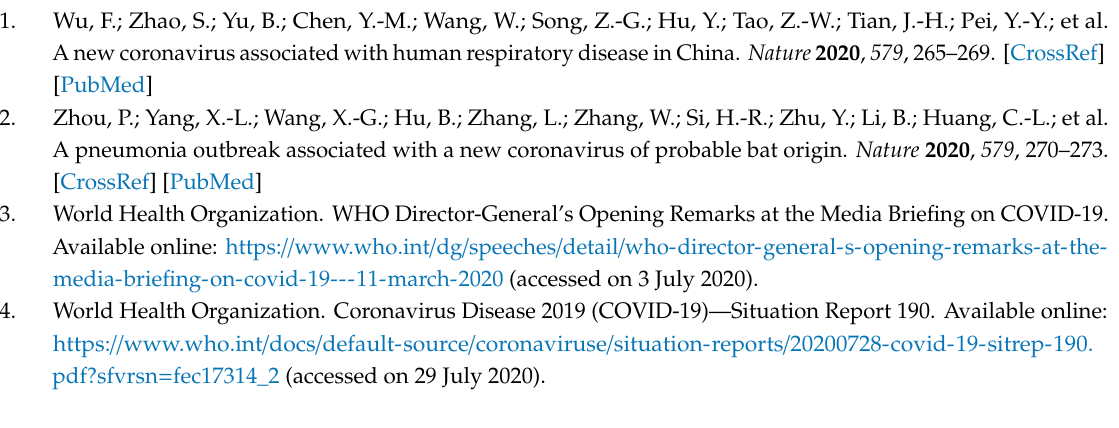
Table S1. Global studies on SARS-CoV-2 prevalence in wastewater and rivers, according to country, January